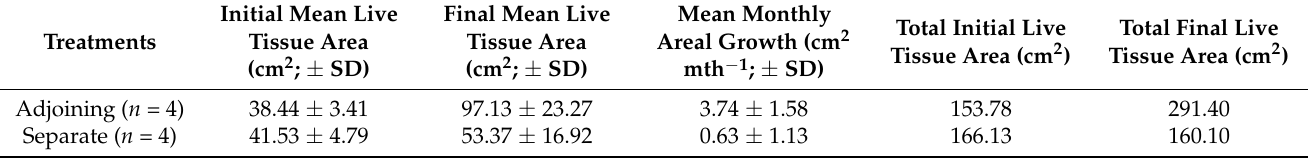
Table 1. Mean live tissue area, monthly areal growth (± SD) and total live tissue area of clusters of Platygyra sinensis , 16 months after transplantation.